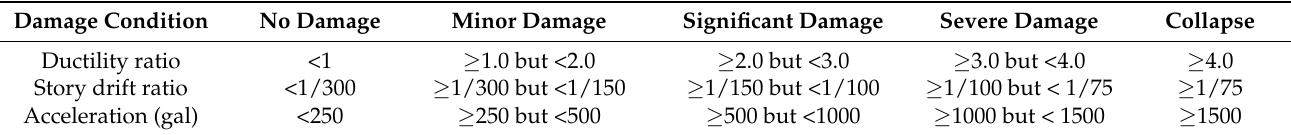
Figure 3. Definition of ductility ratio. Table 1. Proposal of damage condition according to the structural response for damage